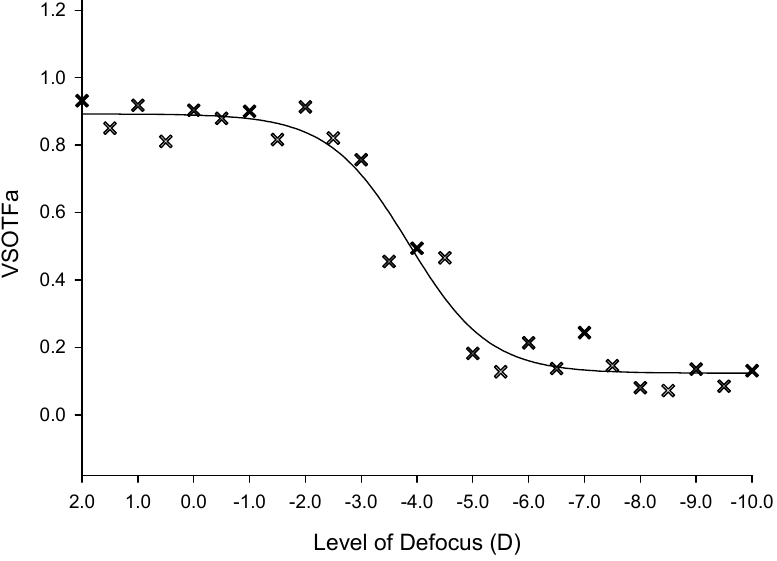
Figure 4. Plot of the sigmoidal fit of VSOTFa IQ metric. One participant’s normalized image quality visual metric to which curve fitting was applied (solid line) in order to determine the initial point of plateau.